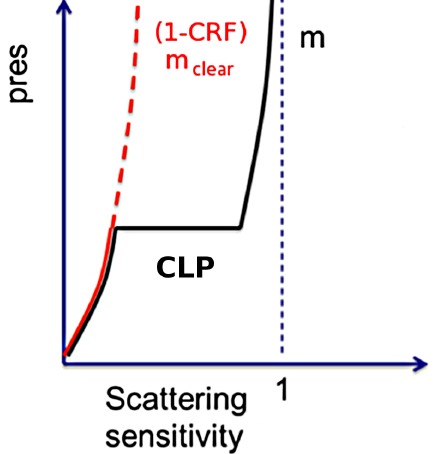
Figure 2. Schematic diagram of the scattering sensitivity above and below the cloud (normalized by the geometric air mass factor): CLP is the cloud level pressure, and m is the total scattering sensitivity, usually defined as ( 1 − CRF ) m clear + CRF m cloudy . The red curve illustrates a residual sensitivity to NO 2 contents below the cloud when conditions are partially